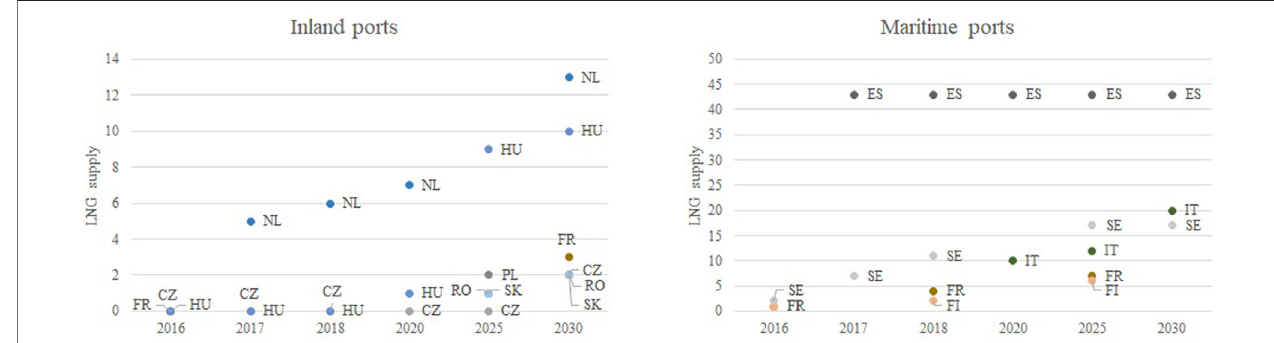
FIGURE 5 | LNG infrastructure deployment in selected countries based on available historical data (2016 – 2018) and NIR targets (2020 – 2030): inland (left) and maritime(right)ports.Note:forinlandportsonlythecountrieswithdeploymentexceeding1pointforthehorizonconsideredareshown.Formaritimeports,thethreshold valueis6points. ForItalyandunlessotherwise statedintheNPF/NIR,LNGportsareunderstoodasmaritimeports.Source:adapted fromEC(2022),basedonNIRand NPF data.